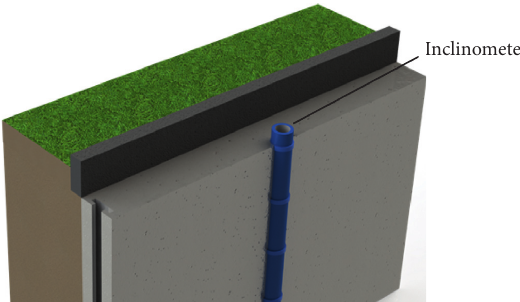
Figure 15: Layout of horizontal displacement monitoring points in the deep layer of the retaining